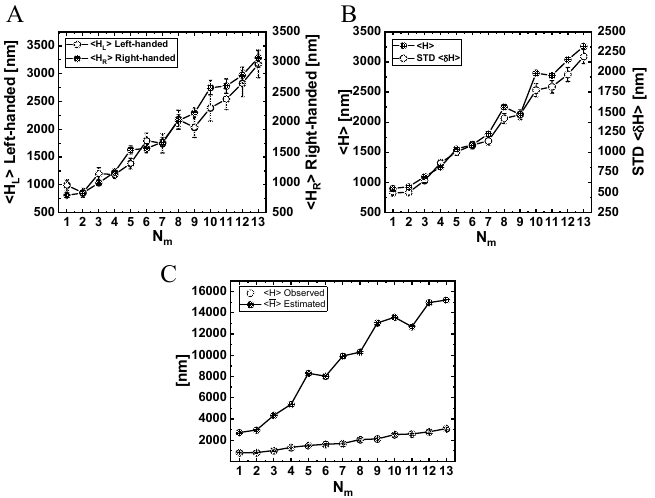
Figure 10 . Analysis of the actual NP helical motion from observed trajectories. (A) Mean ( ±SEM) and STD helical pitch Figure 10. Analysis of the actual NP helical motion from observed trajectories. ( A ) Mean ( ± SEM ) size, 〈(cid:1834)〉 , evaluated separately for left- and right-handed helical vorticities (data are provided in Table S19). (B) Mean and and STD helical pitch size, (cid:104) H (cid:105) , evaluated separately for left- and right-handed helical vorticities STD of the helical pitch size, regardless of the helical vorticity (data are provided in Table S20). (C) Comparison between the actual helical pitch size (from the observed simulated trajectories) and the helical pitch size estimated using the mean (data are provided in Table S19). ( B ) Mean and STD of the helical pitch size, regardless of the values of angular and longitudinal velocities, 〈(cid:1834)(cid:3365)〉 = (cid:2870)(cid:3095) |〈(cid:3104)〉| |〈(cid:2029) (cid:2934) 〉| (data are provided in Table S21).